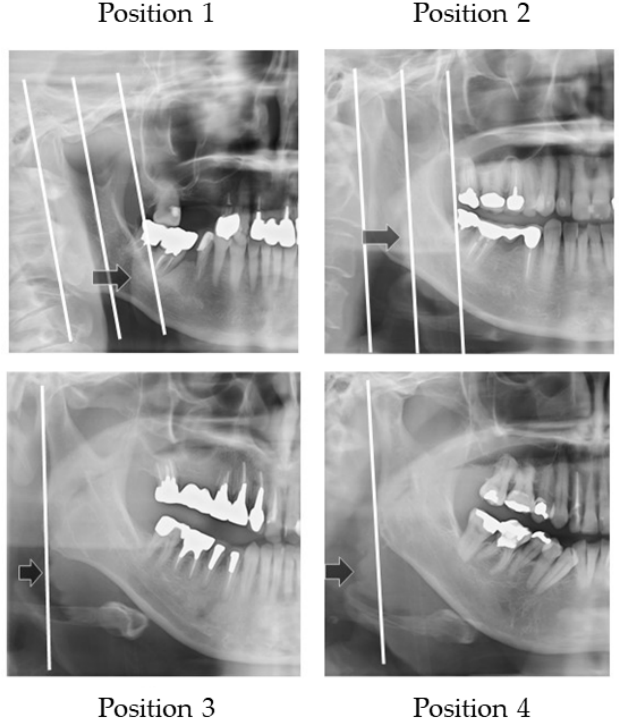
Figure 7. Sample images of width of tongue. Arrows show the outer border of the tongue.